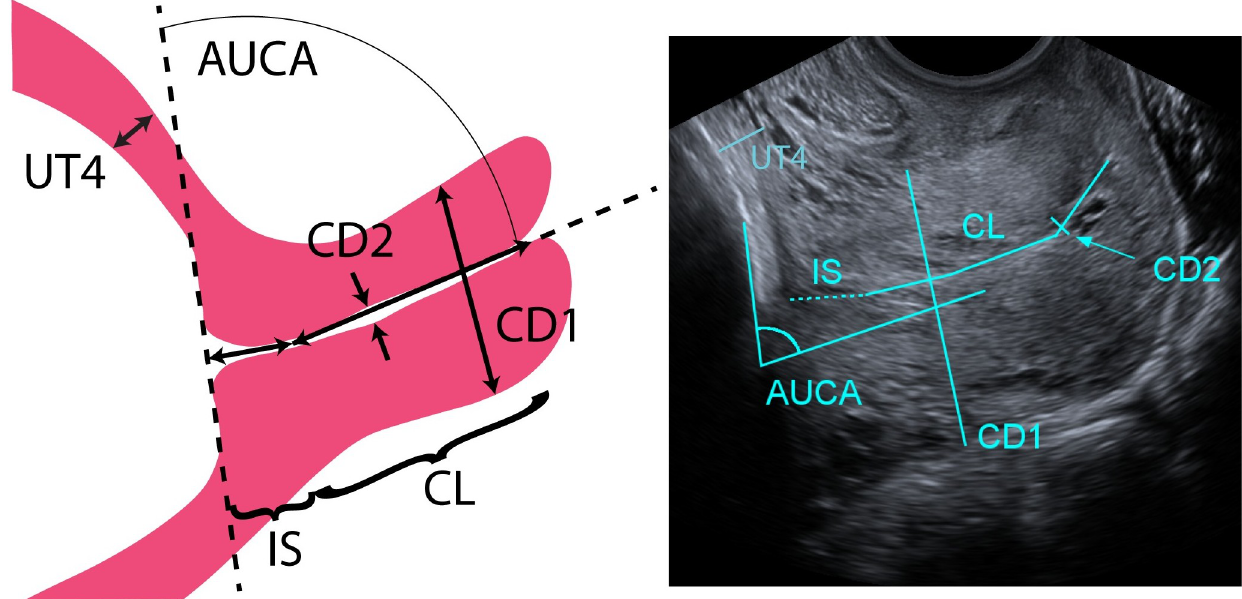
Fig 4. Representative and actual transvaginal (TV) sagittal scan of a pregnant patient at 32 weeks. Left: representative illustration of measurements taken from ultrasounds of the cervix and lower uterine segment in the sagittal view at the maternal midline. Right: actual transvaginal (TV) sagittal view of the cervix and lower uterine segment taken by placing the transvaginal ultrasound probe on the anterior fornix and turning the probe to view the sagittal plane. Measurements taken in the TV sagittal view are: cervical length (CL), outer diameter (CD1), inner cervical canal diameter (CD2), and cervical angle with anterior wall of the uterus